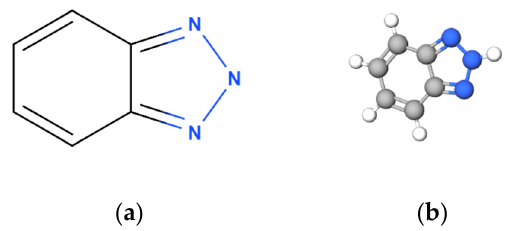
Figure 2. 2D ( a ) and 3D ( b ) chemical structure of benzotriazole (BTA).